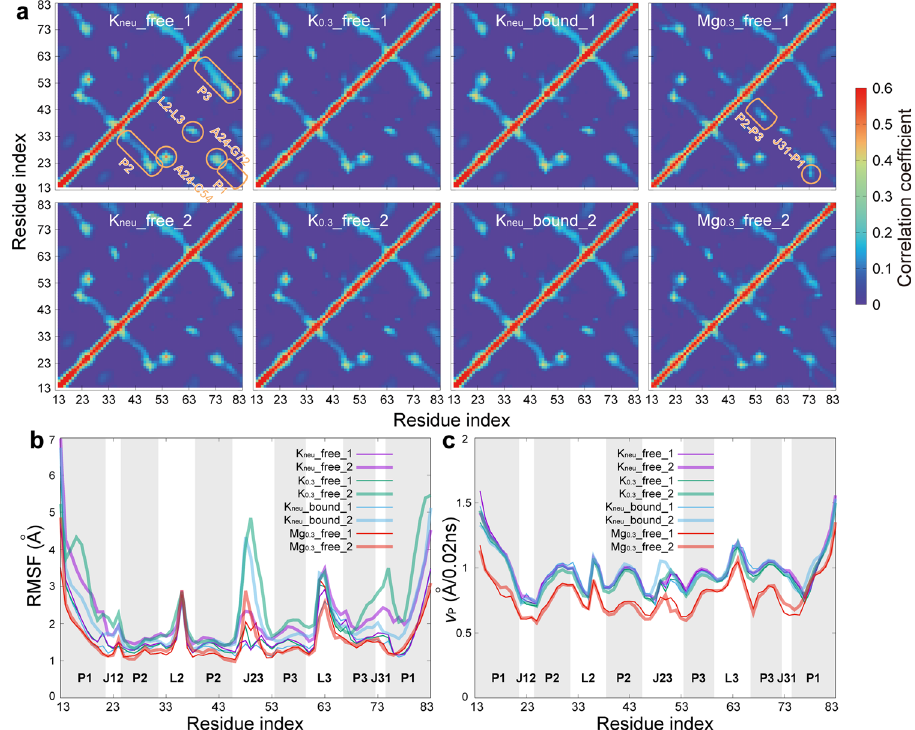
Fig. 8 Structural dynamics of AARA. a The correlation maps of direction of velocity vector between any two phosphate groups for all eight simulation trajectories. The color bar shows the variations in correlation coef fi cient from 0 (dark blue) to 0.6 (red). Several regions showing strong correlation are marked with orange boxes. b The RMSFs of AARA structure for all eight simulation trajectories. The sampling interval is 20 ps; thus, a total of 60,000 conformations are used to calculate the RMSFs for each trajectory. c The velocity of phosphate group on each residue for all eight simulation trajectories. Since the sampling interval is 20 ps, we simply use the displacement of phosphate group in this interval to replace its distance in this interval. Then, the displacement divided by time interval can be used to obtain the approximate velocity of each